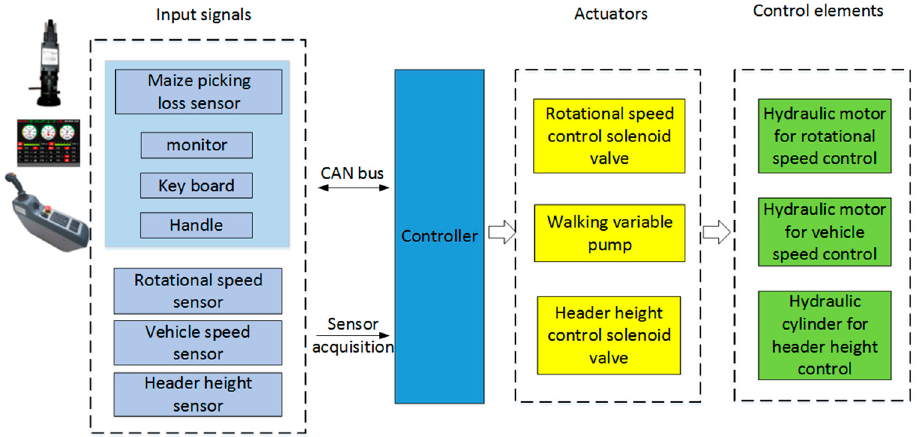
Figure 2. Structure block diagram of the hardware system.